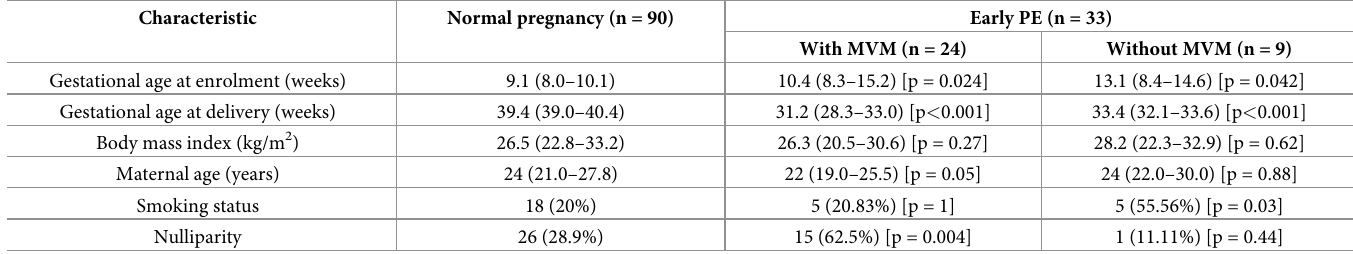
Table 1. Demographic characteristics of the study